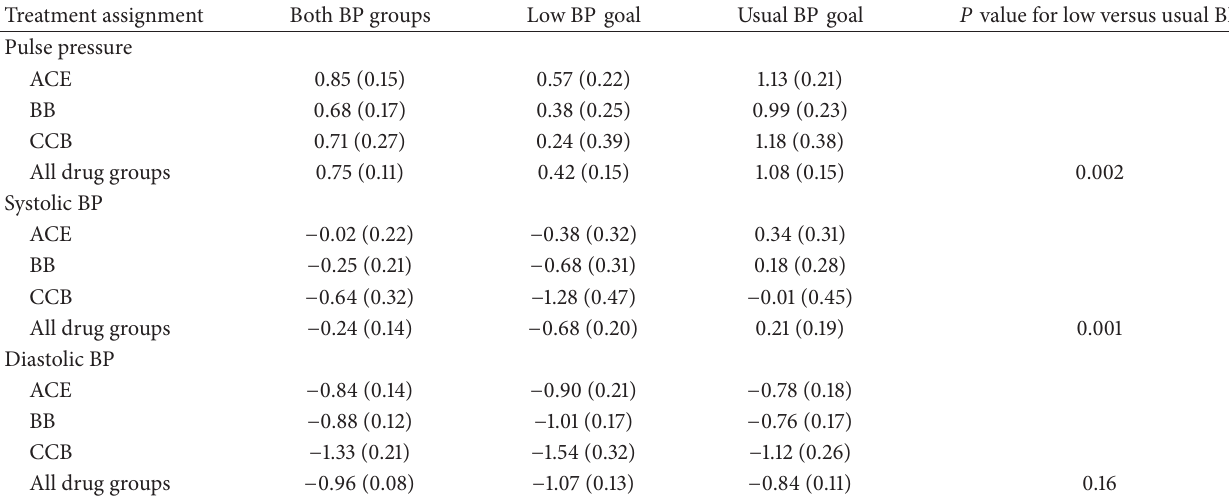
Table 4: Mean (SE) rate of change of blood pressure measurements after 9 months of follow-up by randomized treatment assignment